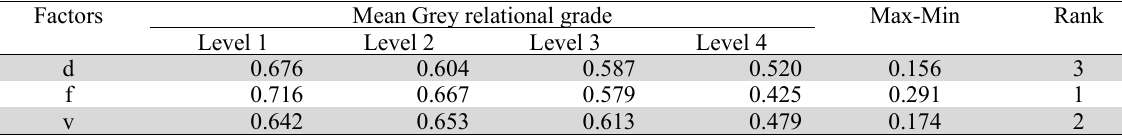
Total mean grey relational grade =